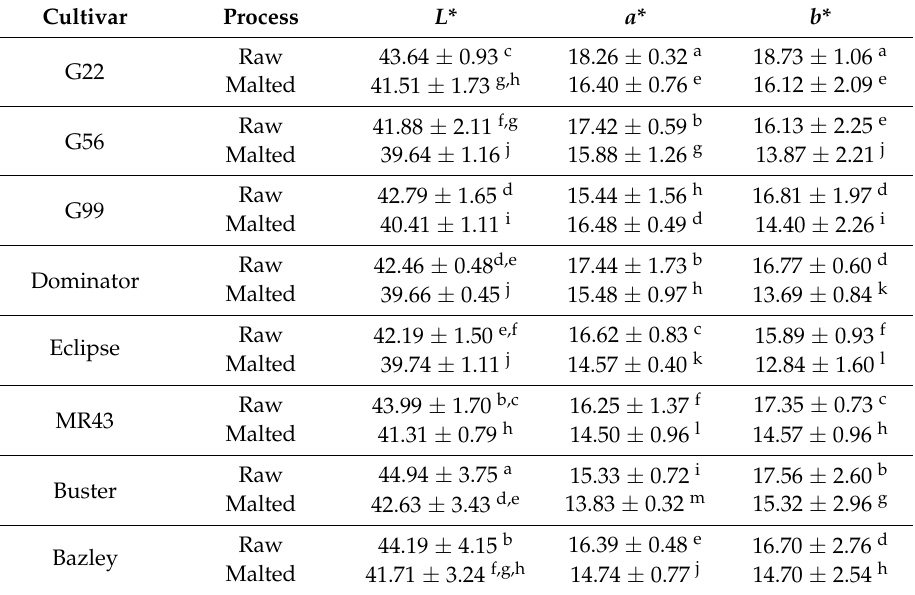
Table 2. Mean comparison of sorghum cultivar and process interaction on grain colour. Values are means ± SD ( n =